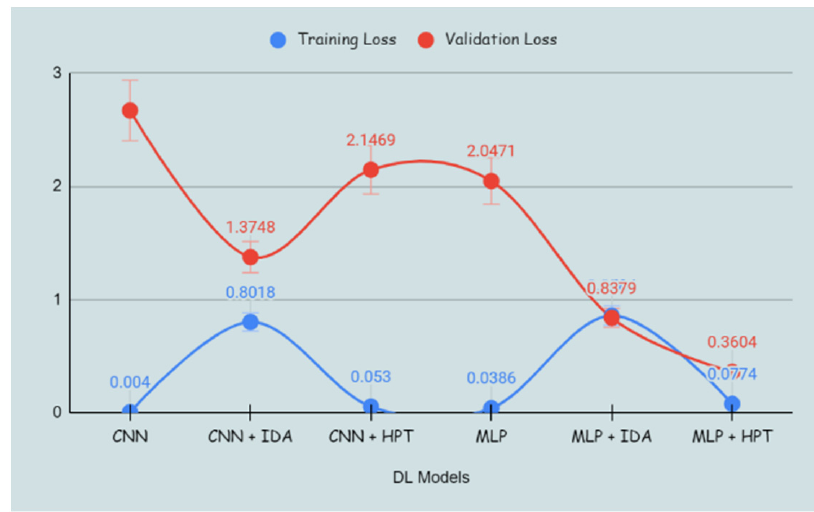
Figure 22. Deep learning models’ training and validation losses.